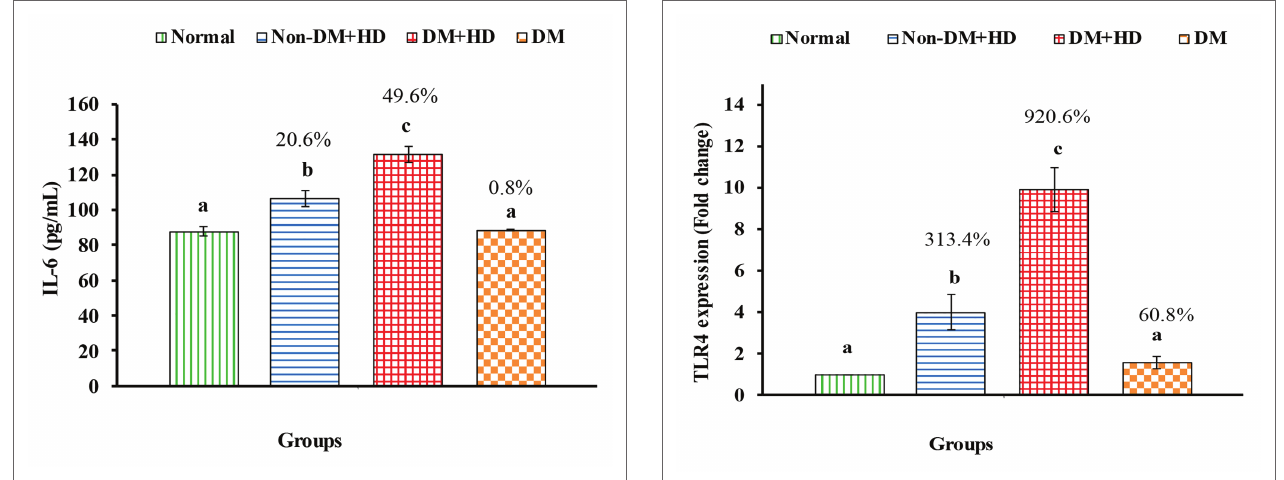
FIGURE 5 | The expression of Toll-like receptor 4 (TLR4) in the blood of non- diabetic and diabetic patients with or without kidney failure. Means, which have different superscript letters, are significantly different at p < 0.05. Percentage changes were calculated in comparison with normal group. Value of p :